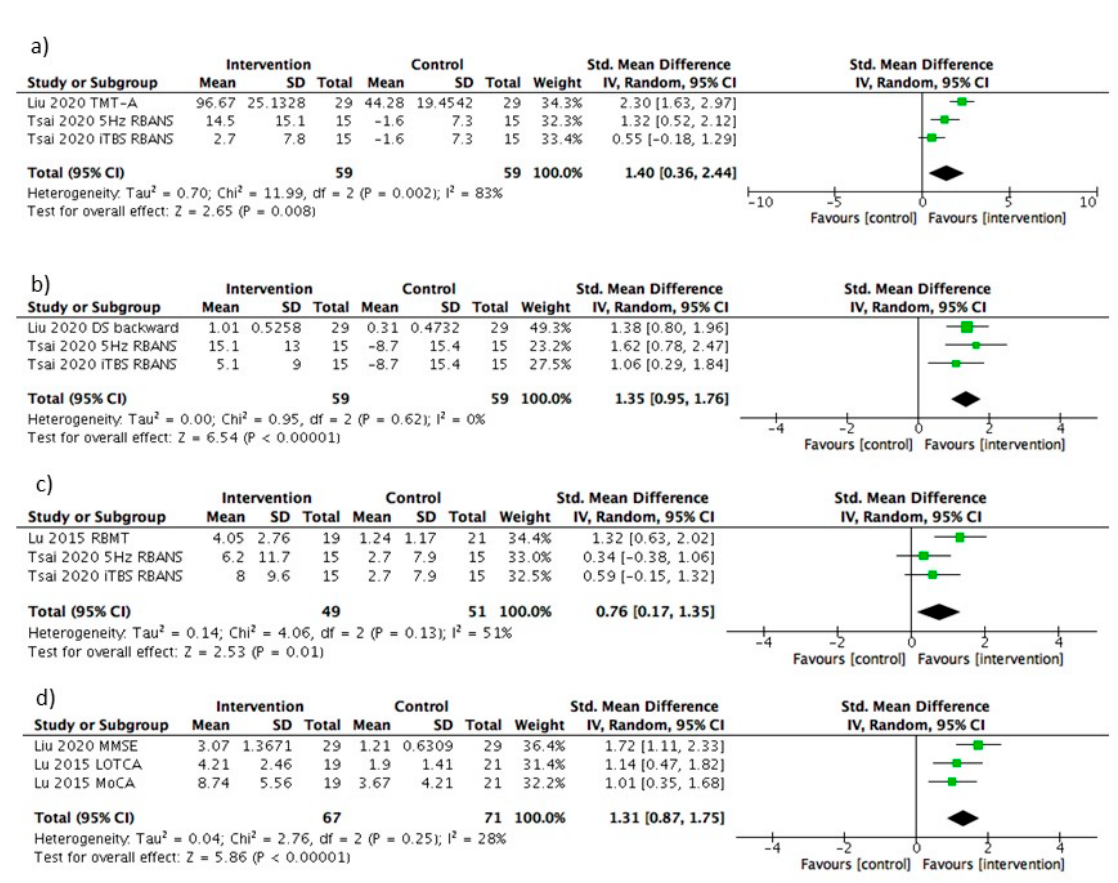
Figure 2. Relationship between stimulation site and neuropsychological test results in rTMS and tDCS. Abbreviations: DLPFC = Dorsolateral prefrontal cortex, PFC= Prefrontal cortex, PPC = Posterior parietal cortex, STG = superior temporal gyrus, LFS = Low frequency stimulation, HFS = High frequency stimulation, iTBS = intermittent theta ‐ burst stimulation.